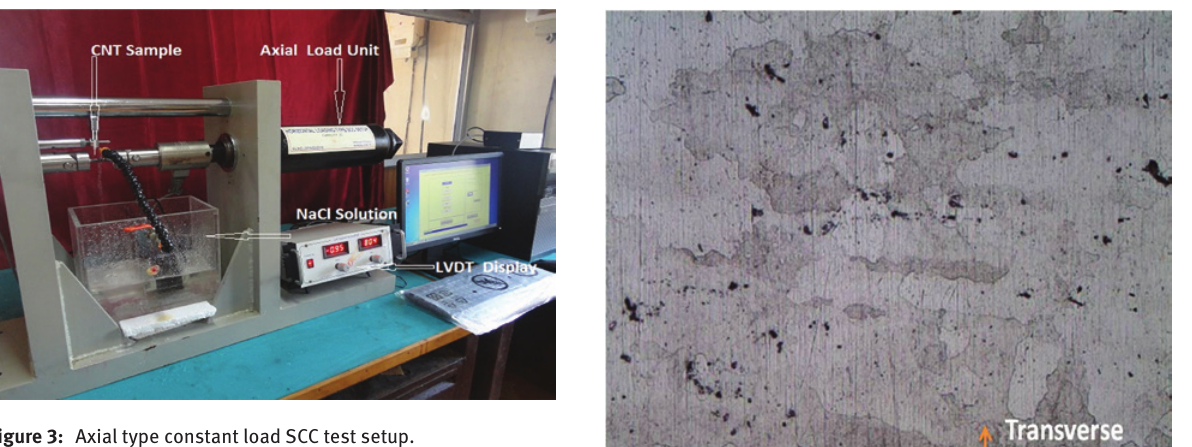
Figure 3: Axial type constant load SCC test setup.